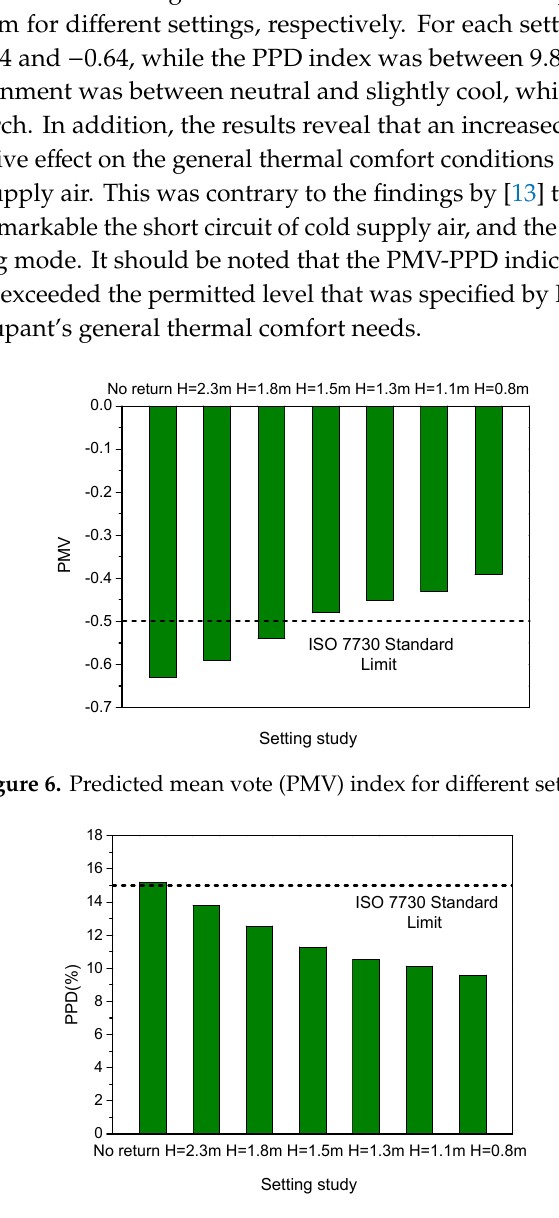
Figure 7. Predicted percentage dissatisfied (PPD) index for different settings.